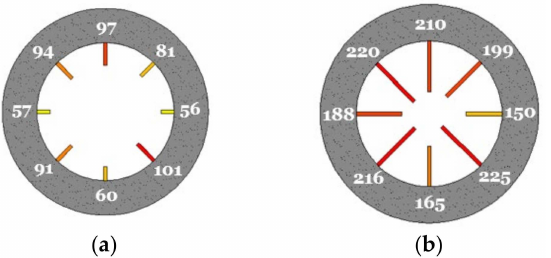
Figure 6. Hoop stresses (MPa) along inner surface of test boss. ( a ) Non-lubricated ( b ) Lubricated. Measurements taken at positions ± ∆ π /4 are compared to the cut positions, and these measurements indicate changes in the stress level compared to the measurements at the cuts. The stress level close ( ± ∆ π /4) to the complete cut at π /2 shows reductions from 97 MPa to 94 MPa, and 81 MPa, respectively. The corresponding values for the opposite partly cut at 3 π /2 show an increase from 60 MPa to 101 MPa, and 91 MPa, respectively. All values for both non-lubricated and lubricated partly cut cases are shown in Figure 6, which resembles a kind of stress distribution in the test